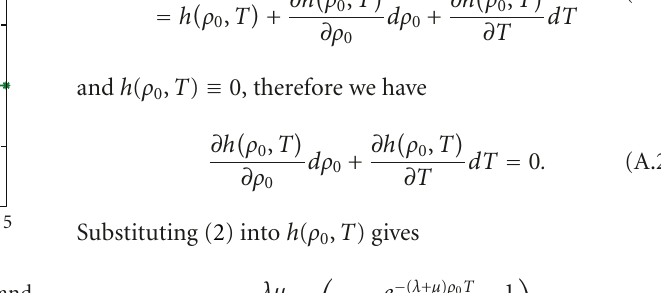
Figure 16: The channel utilization β under access policy π 2 , π PA and π NSA .